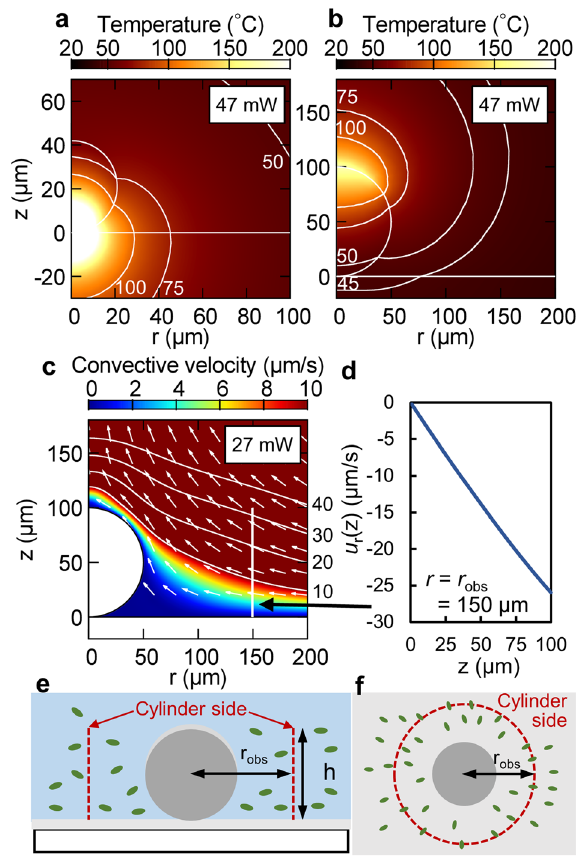
Fig. 4 Simulation of light-induced assembly with bubble-mimetic substrate. The distribution of ( a , b ) temperature and ( c ) convective velocity. Results of simulation for ( a ) a fl at substrate and ( b , c ) bubble- mimetic substrate at a laser power of ( a , b ) 47 mW and ( c ) 27 mW. The white lines show the contour of the temperature, 45, 50, 75, and 100 °C in a and b , and velocity, 10, 20, 30, and 40 µ m/s in c . d r -component of the convective velocity u r (z) at the white vertical line in c ; r = r obs = 150 µ m. e Top view and ( f ) side view of the cylindrical model used to estimate the number of transported